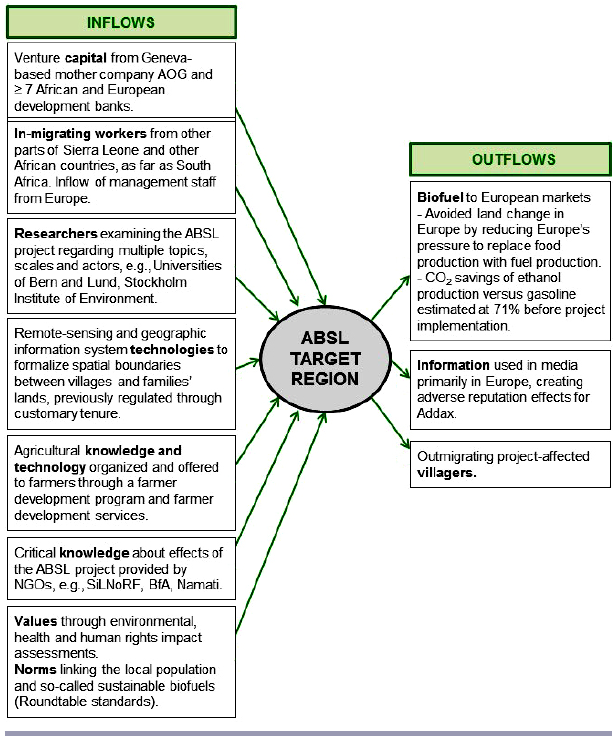
Fig. 4 . Flows intensifying the telecoupling of land use in the Addax Bioenergy in Sierra Leone (ABSL) target region with distant regions. Source: based on Manley et al. 2011, Bürgi 2015, Fielding et al. 2015, Bottazzi et al. 2016, Marfurt et al. 2016, Millar 2016 a,b